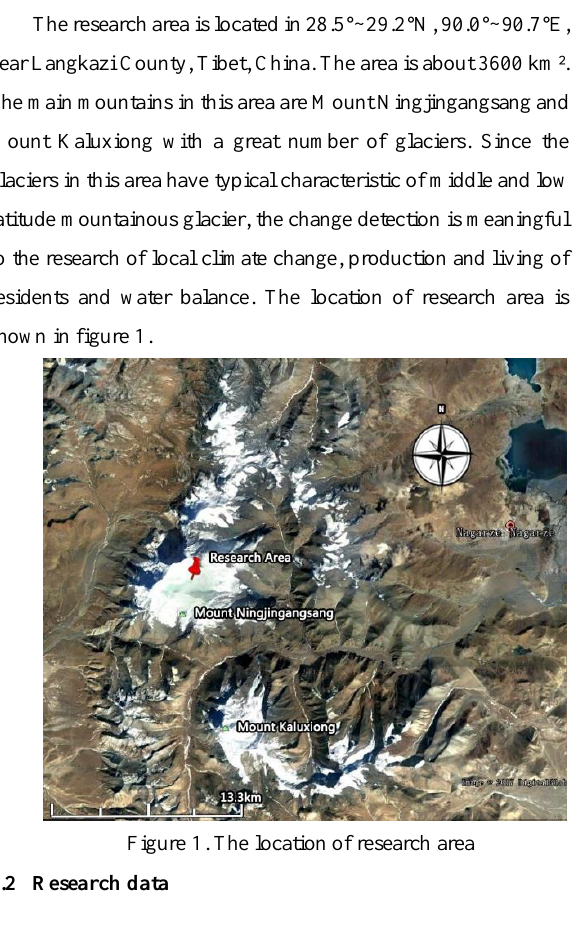
Figure 2. The process of research